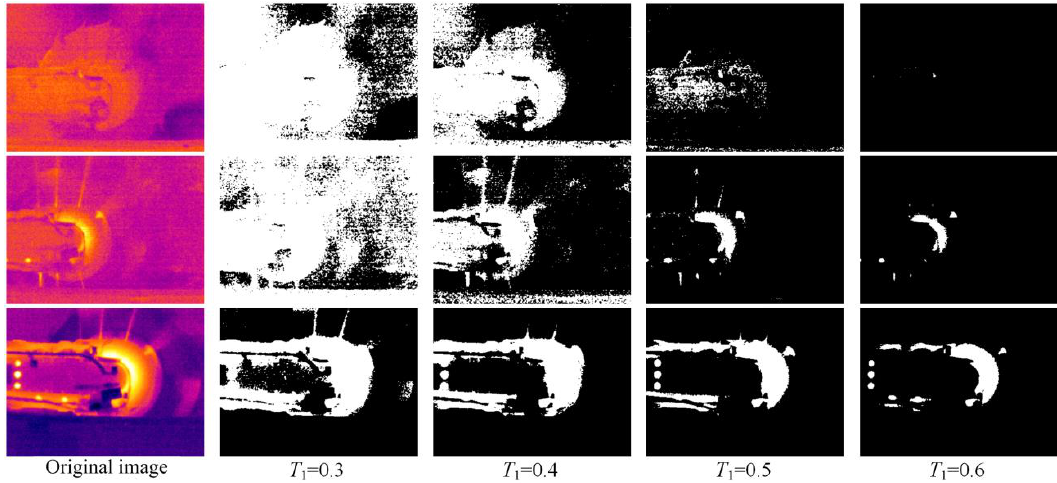
Figure 11. Binarization processing results with different thresholds.